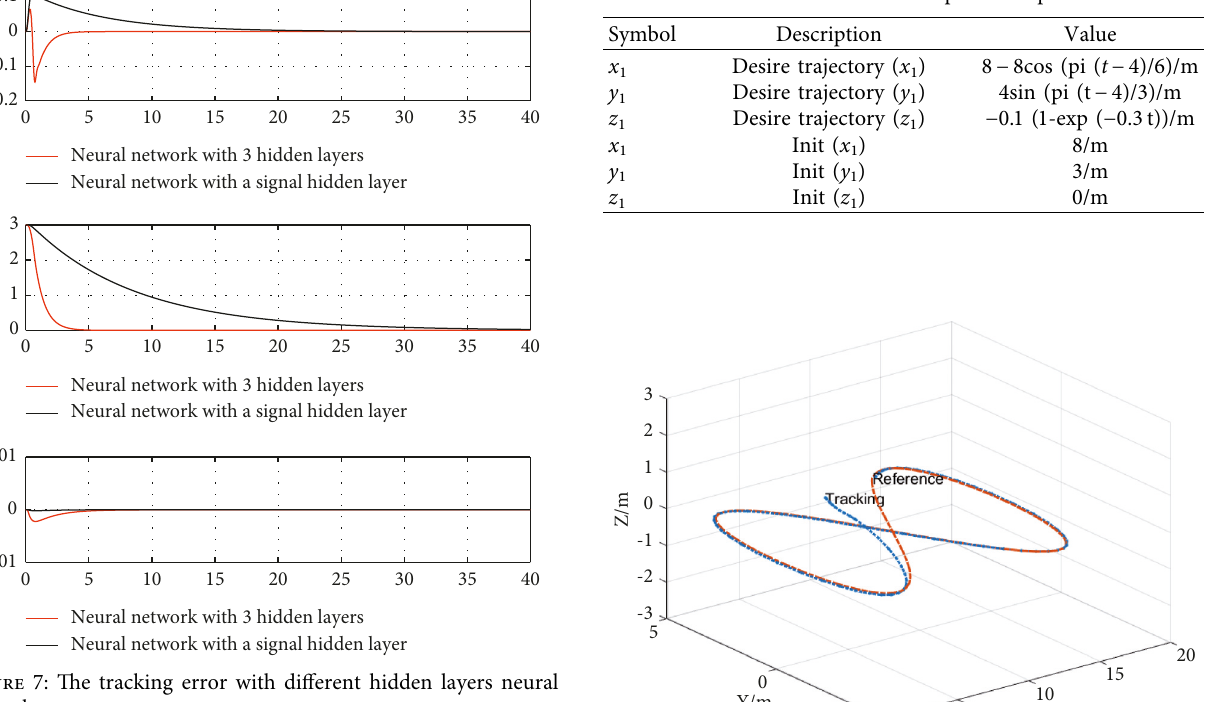
Table 4: Parameters of “8-shaped” 3D spiral curve.